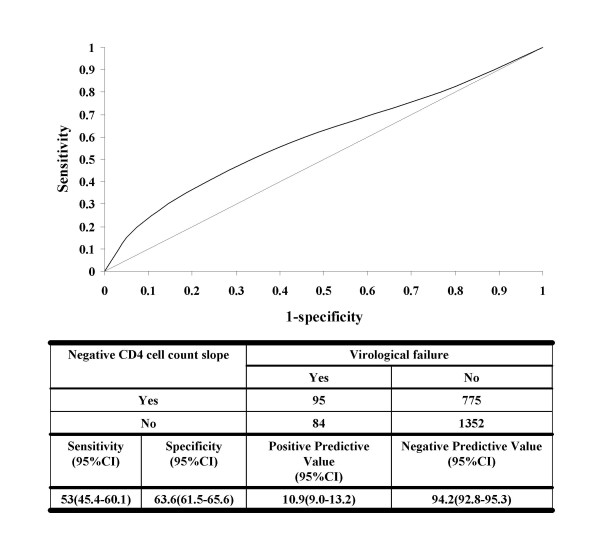
Receiver Operating Characteristic (ROC) curve assessing the association between a negative CD4 cell count slope (ie a falling CD4 count) and virological failure (area under the curve = 0.59).